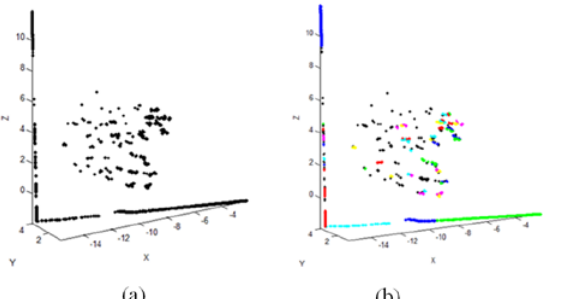
Figure 1.Line segment extraction: (a) laser point in scan profile (b) line segment extraction result.